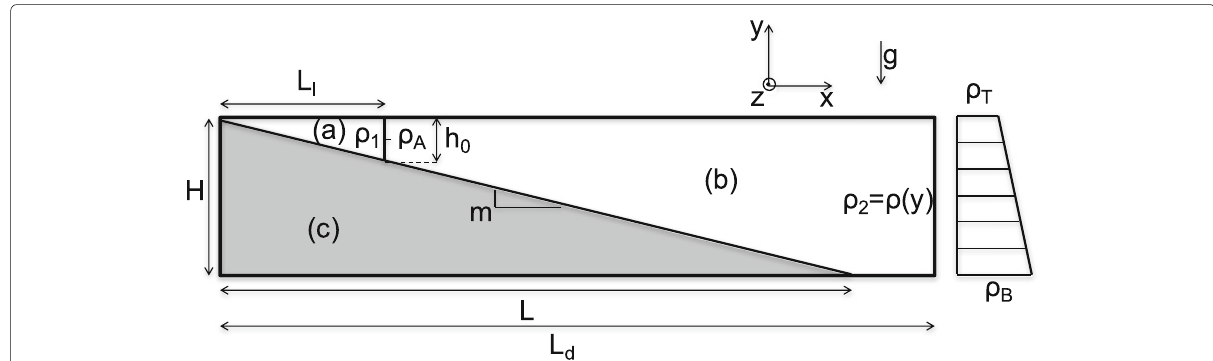
Fig. 1 Problem setup and configuration. a Particle-laden fluid. b Ambient stratified fluid. c Solid region. H and L denote the height and length of the ramp, L d is the horizontal length of the domain, h 0 and L l denote the height and horizontal length of the lock, and m is the slope. ρ 1 is the bulk density of the lock, ρ T is the initial density at the top of the ambient, ρ B is the initial density at the bottom of the ambient, and ρ A is the initial density in the ambient at half-lock